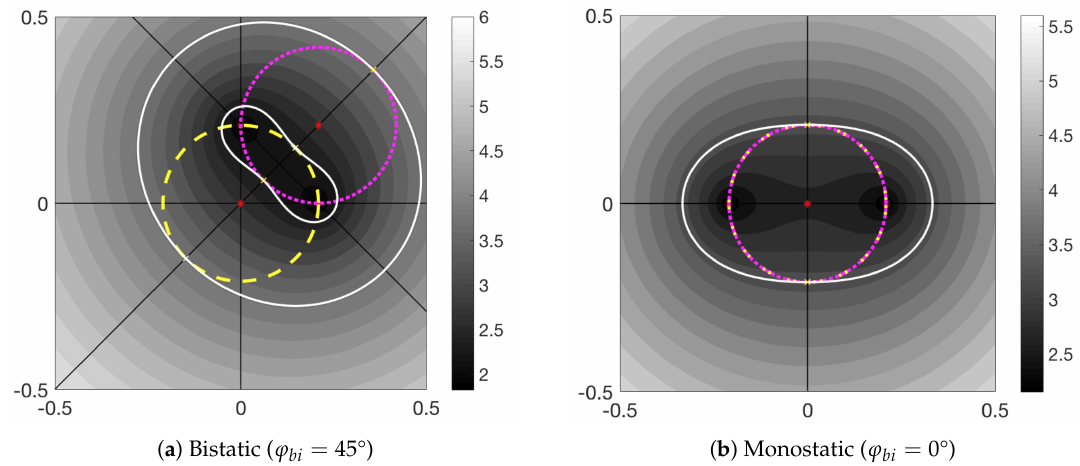
Figure 9. Contours in the p , q plane defined by Equation (36) when m = m (cid:48) = 1. ( a ) Bistatic case with bistatic angle ϕ bi = 45°, ( b ) monostatic case. The electromagnetic singularities are shown for both monostatic and bistatic radars. The yellow dashed circle shows the singularities defined by Equation (50) and the magenta dotted circle shows those defined by Equation (51). In the monostatic case, Equations (50) and (51) are equal and hence both circles are in the same location. The white contours highlight the frequencies tangential to the